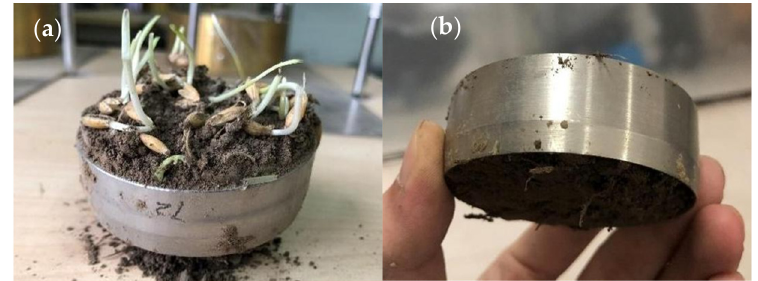
Figure 4. ( a ) Sampling with cutting ring; ( b ) completed sampling.